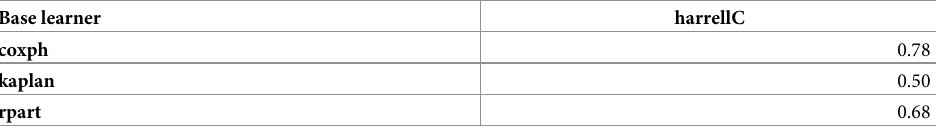
performance on data that had not been observed before. Base learner refers to the type of machine learning model used in the pipeline including kaplan (Kaplan-Meier), coxph (cox proportional hazards), or rpart (tree based survival